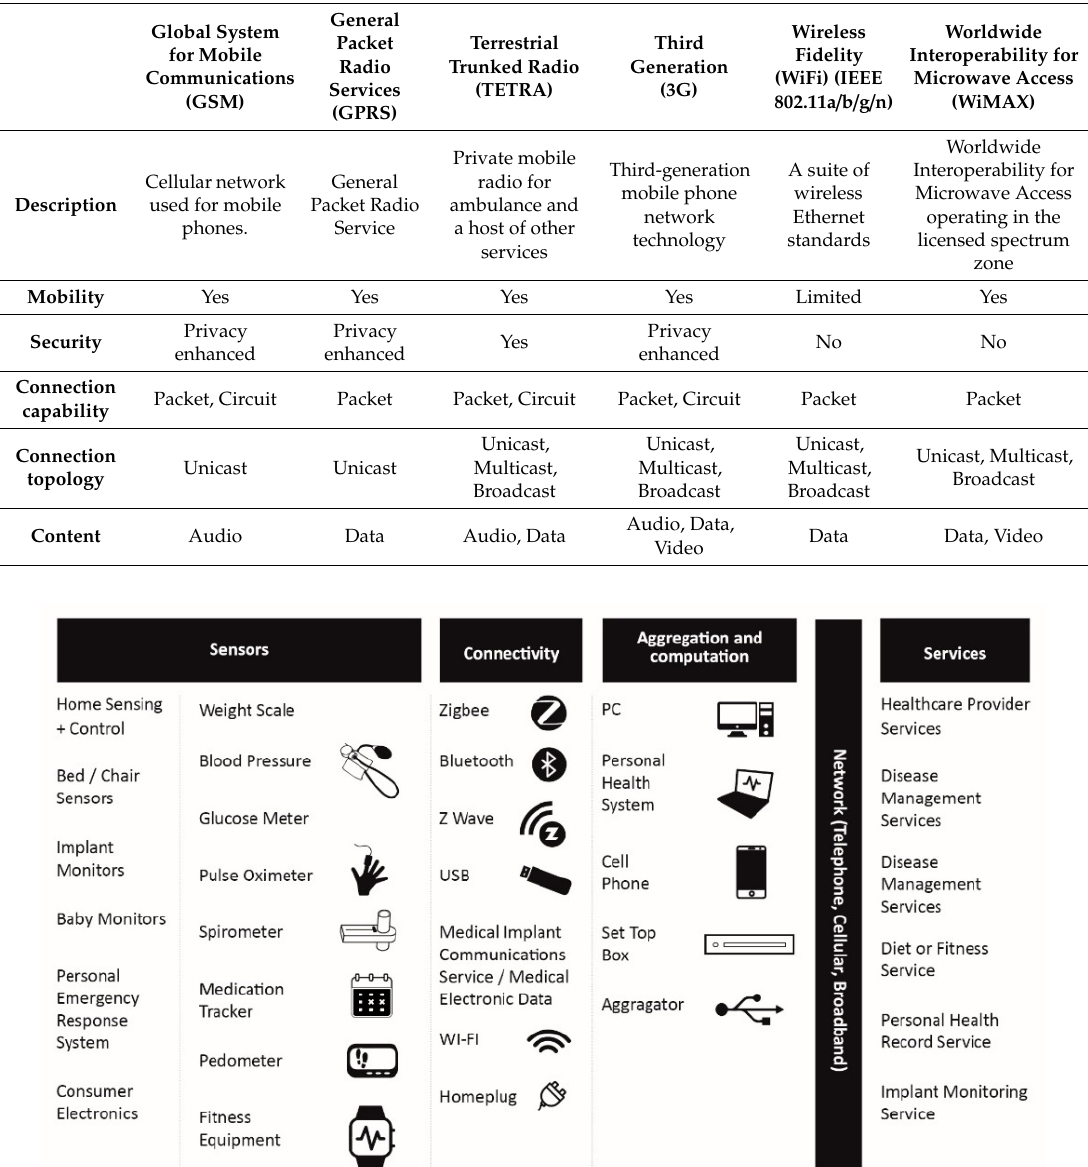
Table 3. Summary of wide area communication technologies for eHealth applications [45].